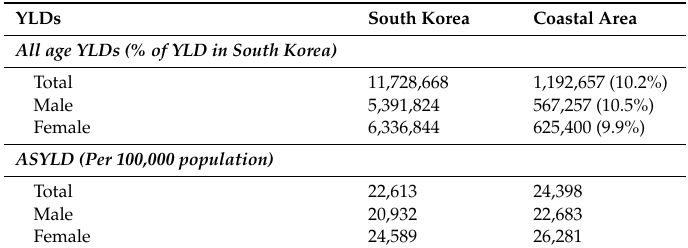
Table 2. YLDs in South Korea and coastal areas, by sex,